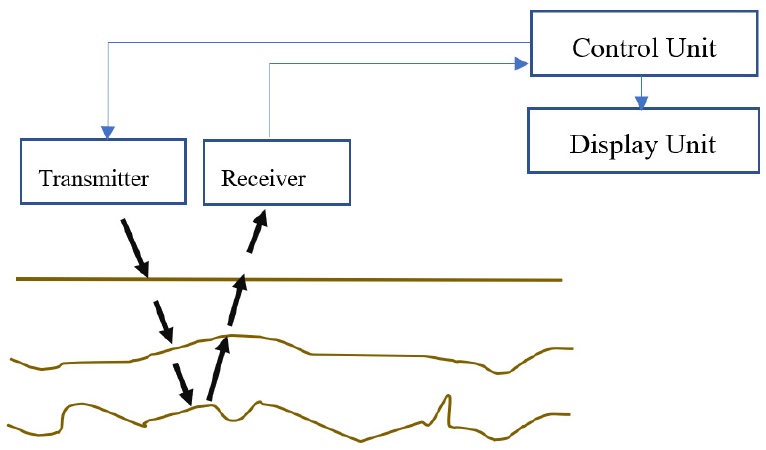
Figure 4. Schematic block diagram of the GPR surface function